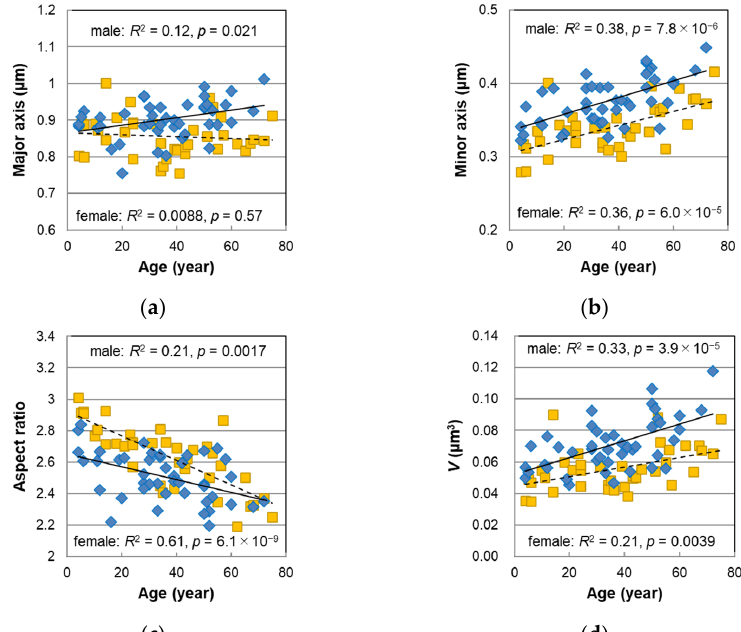
Figure 3. The age dependencies of the morphological parameters determined for the melanosomes isolated from non-chemically treated Japanese male (diamonds) and female (squares) pigmented hairs. ( a ) Mean major axis. ( b ) Mean minor axis. ( c ) Mean aspect ratio. ( d ) Mean volume V with an assumption of an ellipsoid. Lines represent the fitted curves. Solid line denotes male sex and dashed line denotes female sex. The coefficients of determination and p -values are shown in each figure.